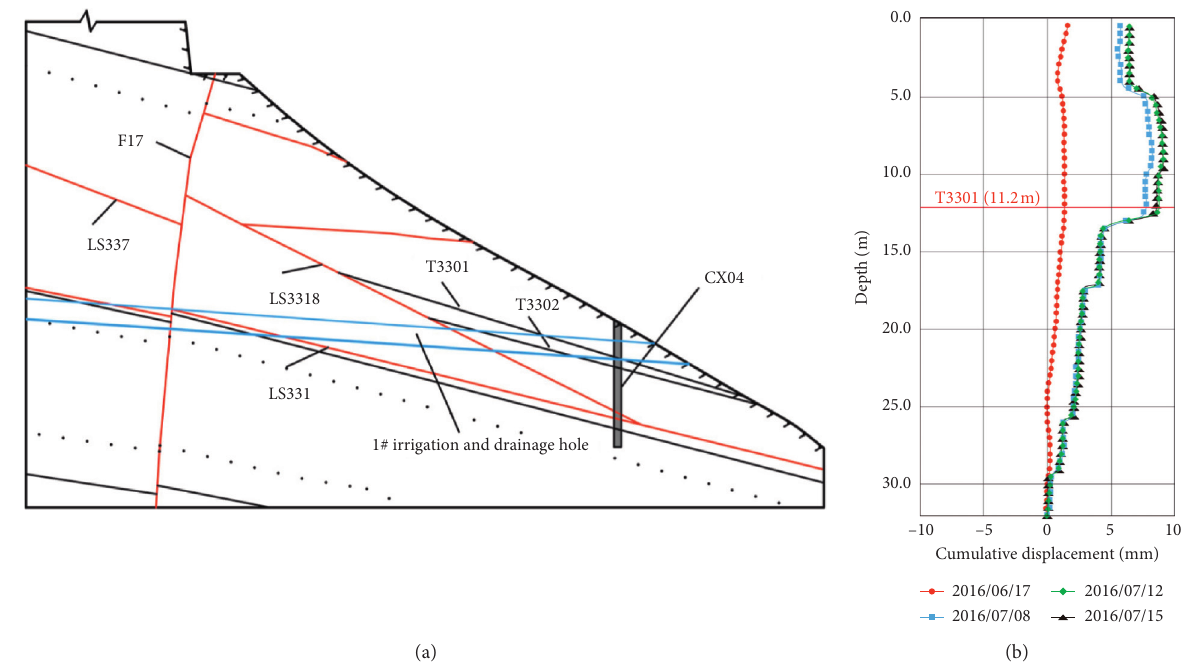
Figure 17: Conventional monitoring result: (a) the location of the CX04, and (b) cumulative displacement data of CX04.